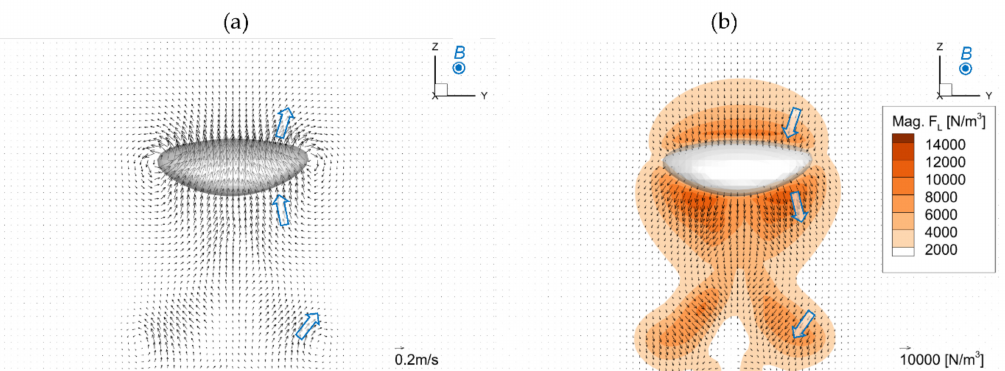
Figure 21. Distribution of Lorentz force vectors for B 0 = 0.14 T: ( a ) in the x = 0 plane, including the color contour of the absolute magnitude of the force, and ( b ) in the y = 0 plane, with the color contour here representing the z -component of the force. Note that the x -component of Lorentz force is zero in the y = 0 plane.